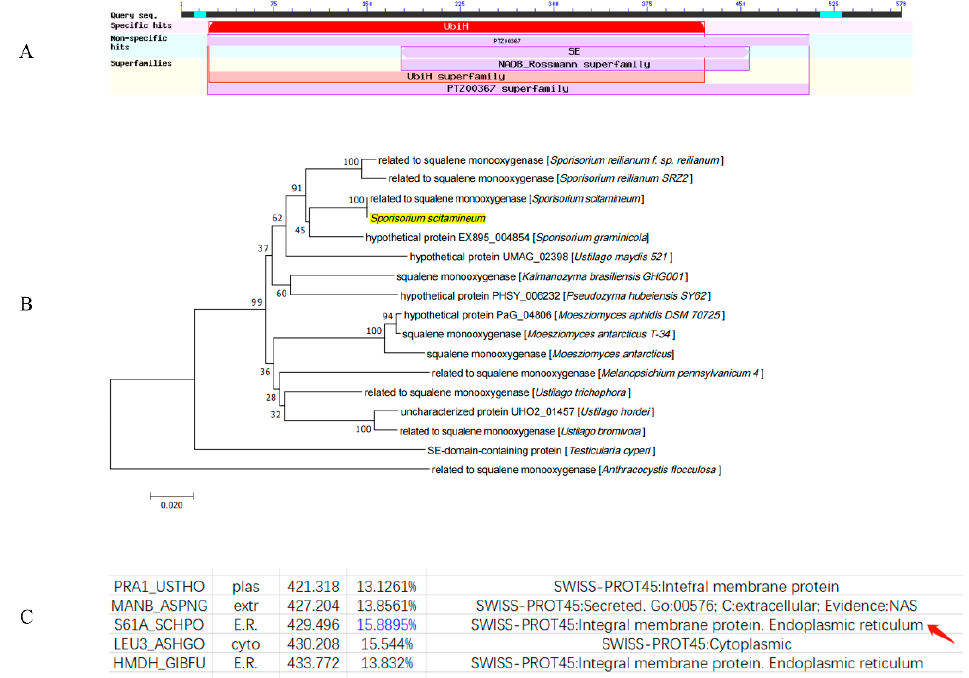
Figure 1. Domain and phylogenetic analysis of the SsCI80130 gene encoding squalene monooxygenase in S. scitamineum . ( A ) The purple “SE” part in the figure showed that predicted protein encoded by the SsCI80130 gene was squalene monooxygenase. ( B ) Phylogenetic tree analysis of the protein encoded by the SsCI80130 gene; Arabic numerals at the node edge of the tree indicate the degree of credibility of the phylogenetic tree (using 1000 bootstrap replicates). The protein encoded by the SsCI80130 gene is highlighted in yellow. ( C ) The subcellular localization prediction of the protein encoded by the SsCI80130 gene. The result of predicted localization is marked with red arrow. The maximum percentage of matching results is marked in blue.